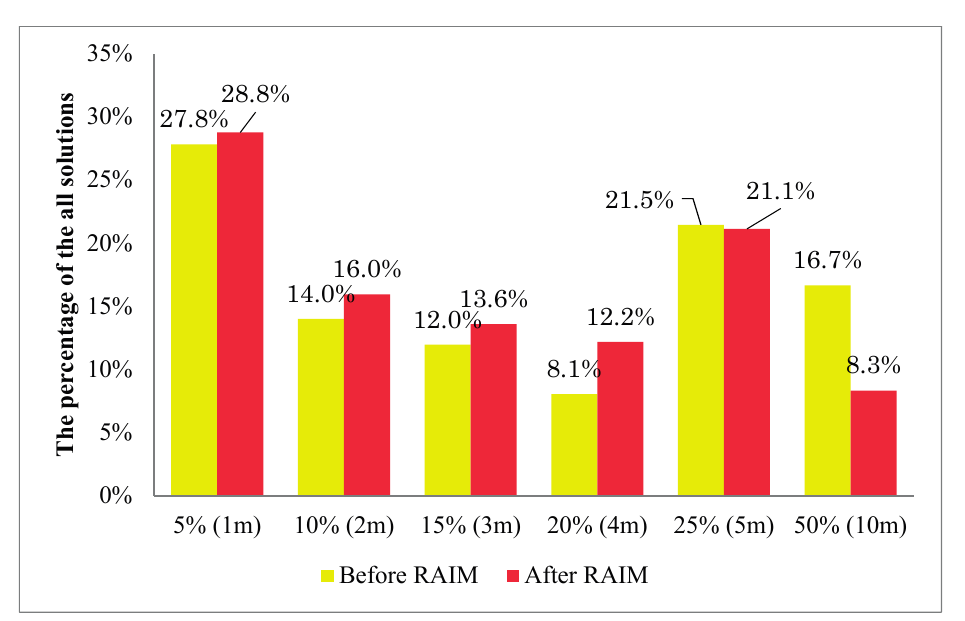
Figure 15. Histogram of the lateral positioning error of the proposed 3D map method before and after using the RAIM satellite selection method in the middle urban canyon.